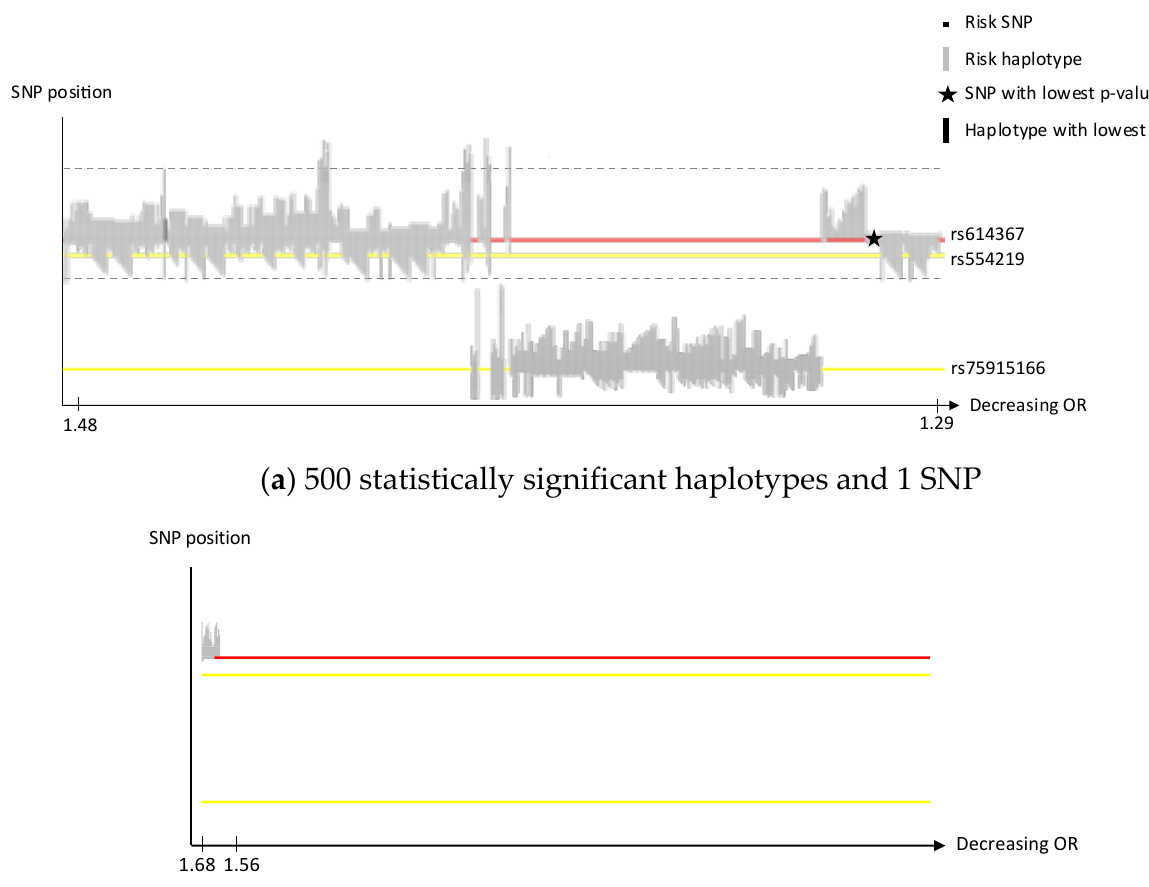
Figure 2. Chromosome 11, haplotypes and SNPs sorted on OR. ( a ) SNP position on the y -axis. Corresponding OR on the x -axis. No gene in the area. The red line indicates the position of the SNP with the lowest p -value. The two yellow lines indicate the position of two previous published BCAC SNPs within the area. The dashed lines indicate the position of the proximal and distal SNP of the significant haplotype of window 50 with the lowest p -value; ( b ) axis, red and yellow lines illustrated as in ( a ).